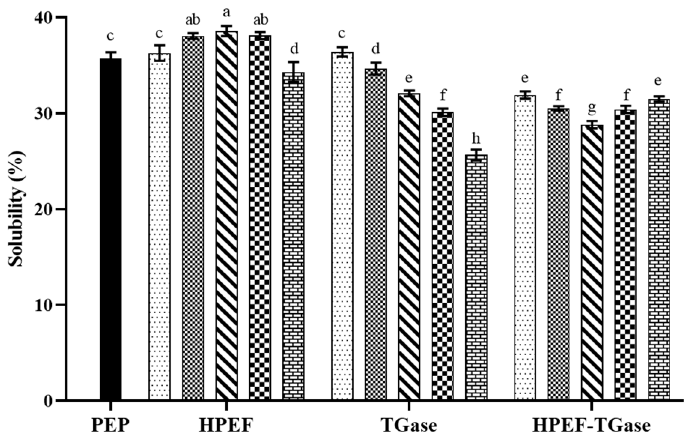
Figure 8. The effects of HPEF (500, 1000, 1500, 2000, and 2500 V/cm), TGase (0.25, 0.5, 1, 2, and 4%), and compound treatment (HPEF-500, 1000, 1500, 2000, 2500 V/cm; 1% TGase) on the solubility of PEP. The different lowercase letters indicate a significant difference between groups ( p < 0.05).